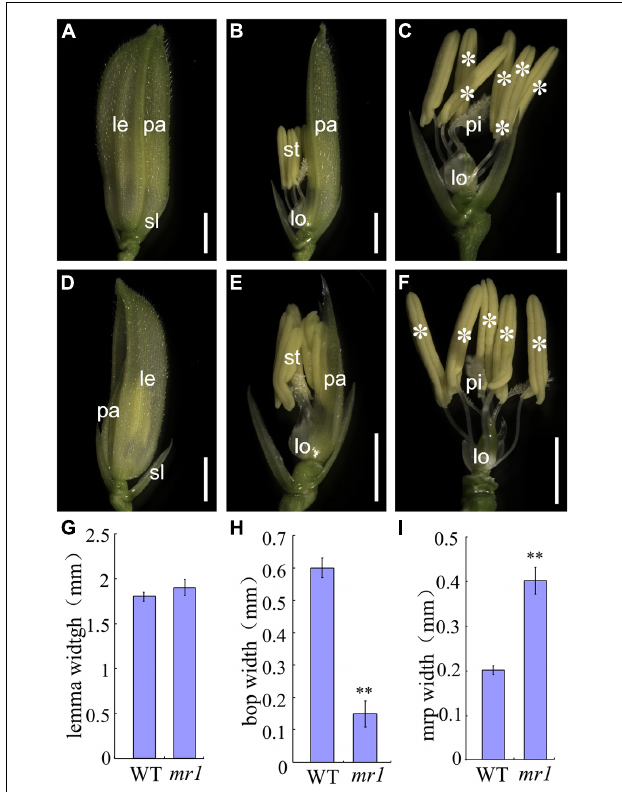
FIGURE 1 | Phenotypes of wild-type and mr1 florets. (A) Wild-type floret. (B) Wild-type floret without lemma. (C) Wild-type floret without lemma and palea. (D) mr1 floret. (E) mr1 floret without lemma. (F) mr1 floret without lemma and palea. (G) Lemma width. (H) Bop width. (I) mrp width. le, lemma; pa, palea; sl, sterile lemma; lo, lodicule; st, stamen; pi, pistil. Asterisk indicates the stamen. Bars, 2 mm in (A–F) . ∗∗ Significant difference at p < 0.01 compared with the wild-type by Student’s t -test. Error bars indicate